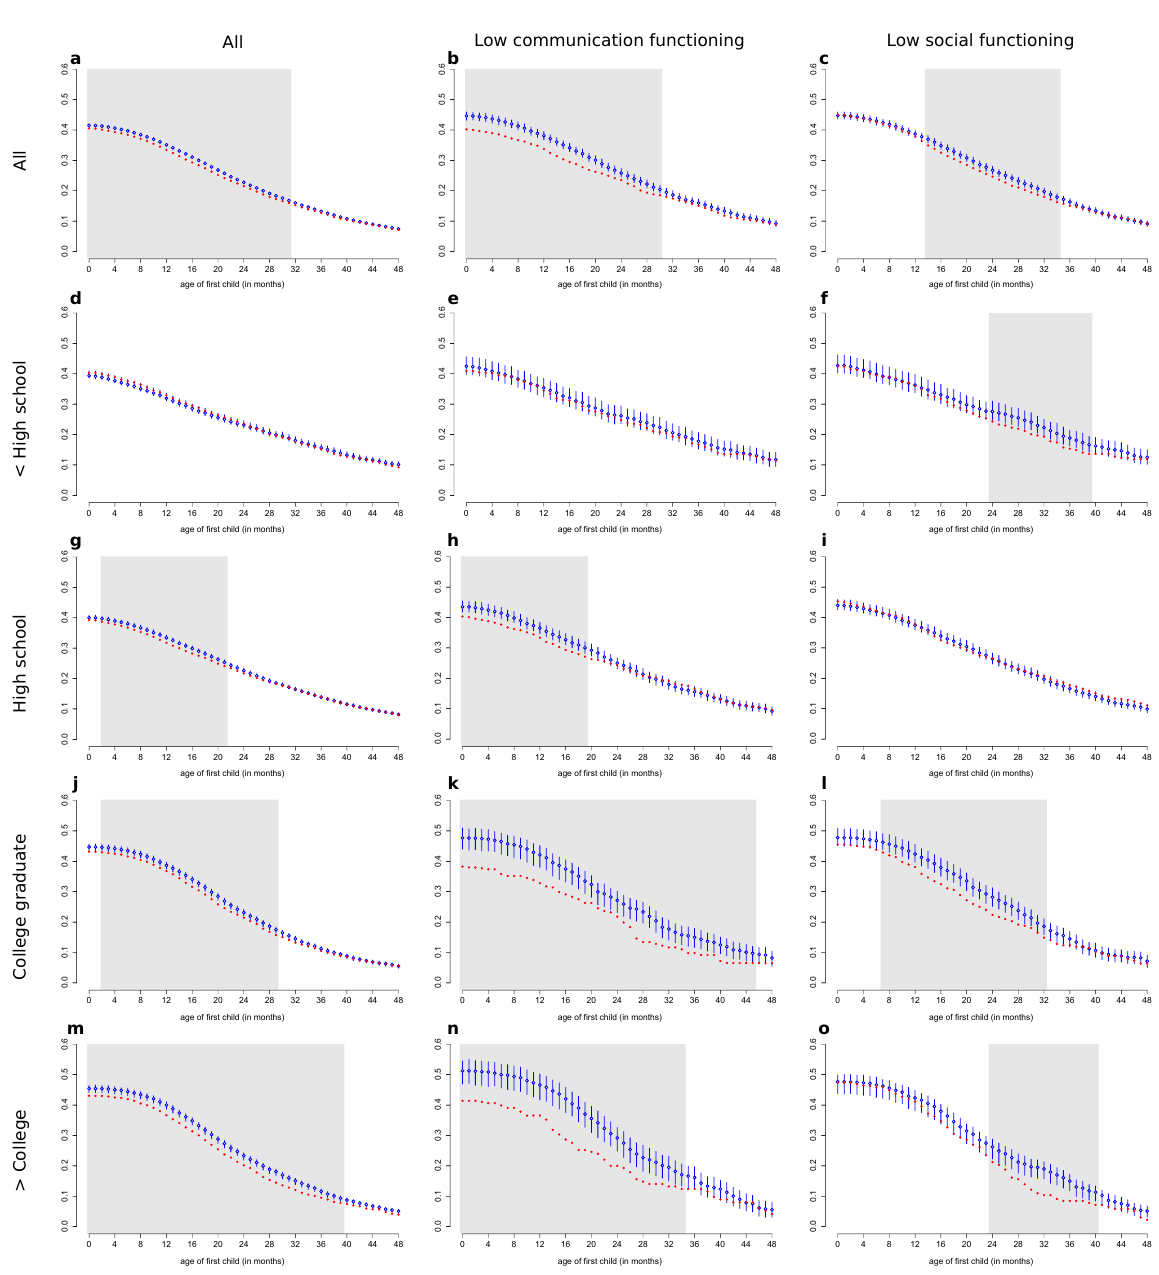
sociological science |